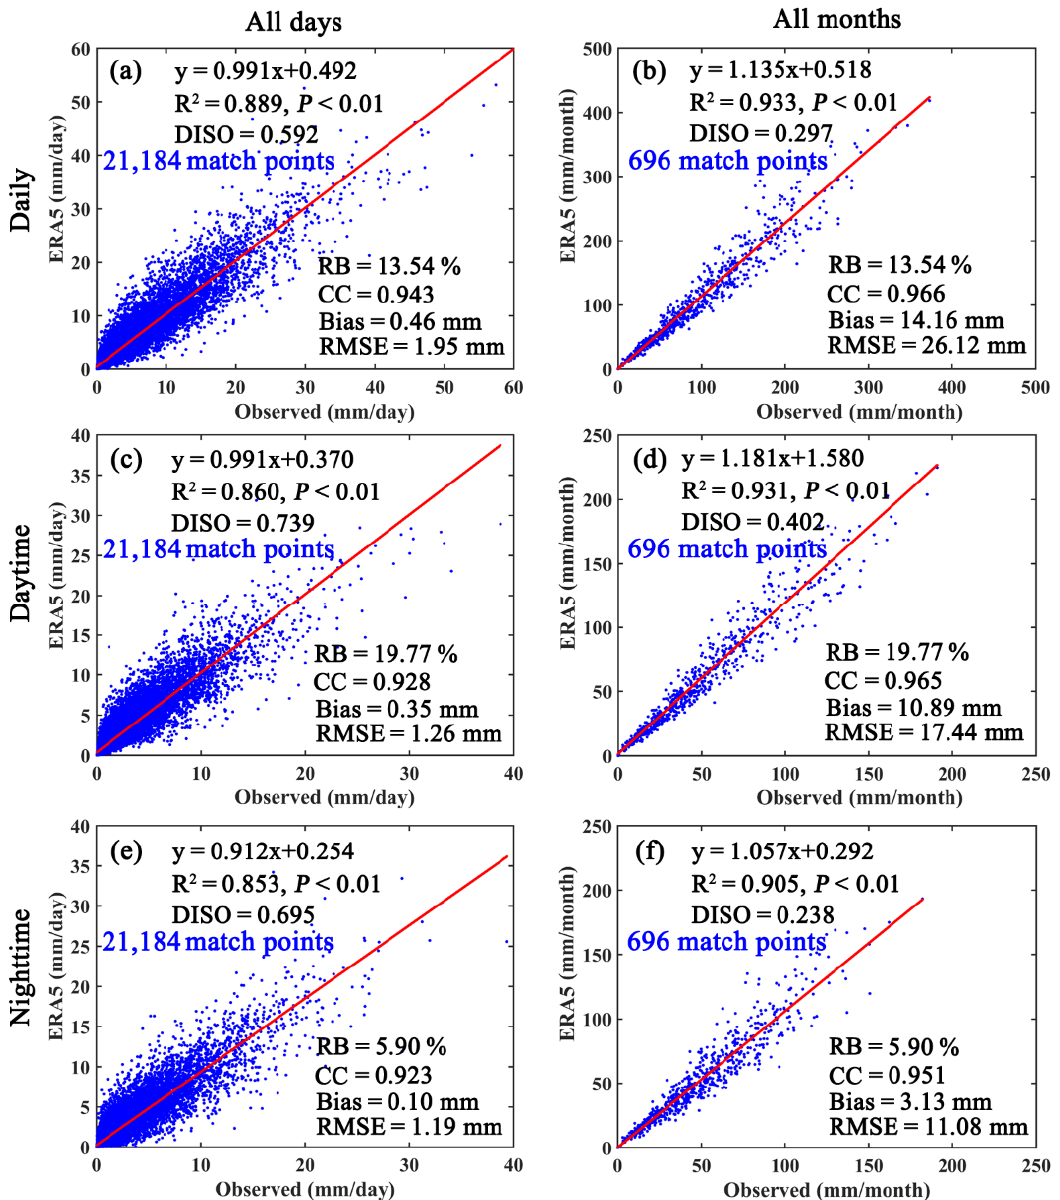
Figure 2. Scatterplot of daily ( a , b ), daytime ( c , d ), and nighttime ( e , f ) precipitation from surface observational stations and their corresponding ERA5 grid points in the YRD for the period 1961–2018. The left (right) column represents all-day (all-month) values, and solid red lines denote linear regression lines. The 21,184 and 696 matching points on the all-day and all-month scales represent the temporal comparisons over 21 and 184 days and 696 months, respectively.